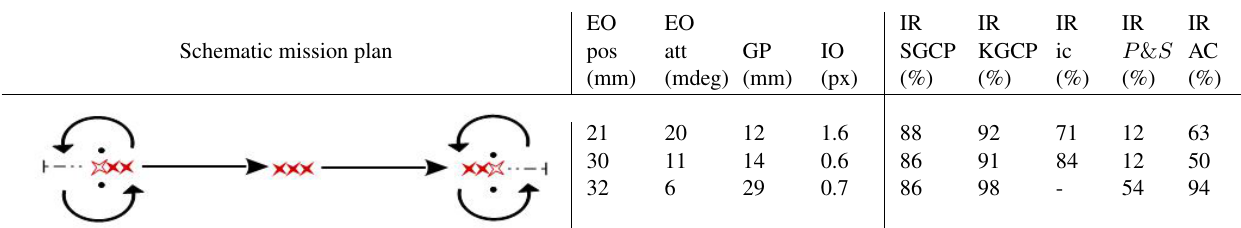
Schematic mission plan